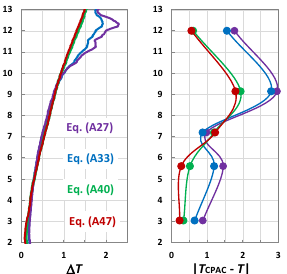
Figure 15. (2 October 2014) Comparative analysis of the abso- lute temperature uncertainties yielded by using Eqs. (A27), (A33), (A40), and (A47) and of the difference in modulus between temper- ature values retrieved from the CPACs and IMCES lidar